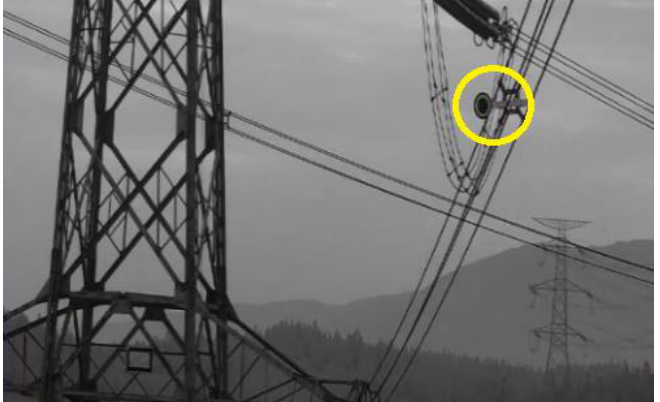
Figure 7. The installation of infrared light tag.